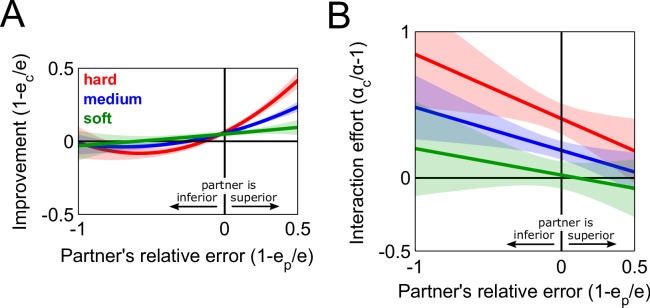
Results of physical interaction between humans through different coupling dynamics.(A) Improvement, defined as the tracking error in a solo trial minus the error in the preceding connected trial, as a function of the relative error, defined as the difference in tracking errors between the partners in the solo trial. The improvement was modulated as a function of the coupling stiffness such that the worse partner (positive in the horizontal axis) improved more with the hard than with the soft interaction. However, the hard interaction did not hinder the better partner’s performance. (B) Interaction effort, defined as the effort expended during a solo trial minus the effort in the preceding connected trial, as a function of the relative error. The effort was estimated as the sum of the mean muscle activations, normalized with respect to torque, from a wrist flexor and extensor pair. As with the improvement, the interaction effort is modulated by the softness of the interaction. Only the better partner in the hard and medium interactions exerted more effort in comparison to solo trials.